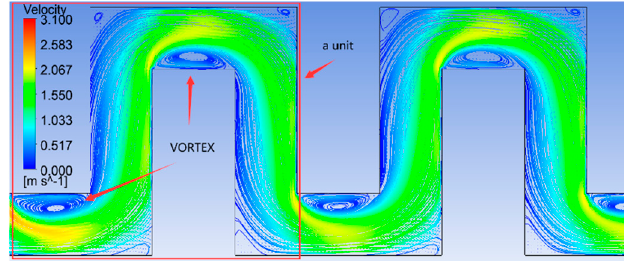
Figure 6. Streamlined diagram of the A emitter.